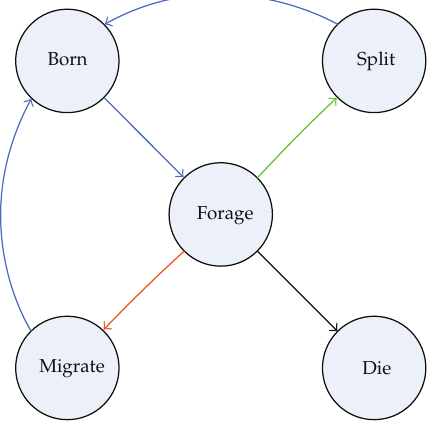
Figure 2: State transition in lifecycle model of bacteria in